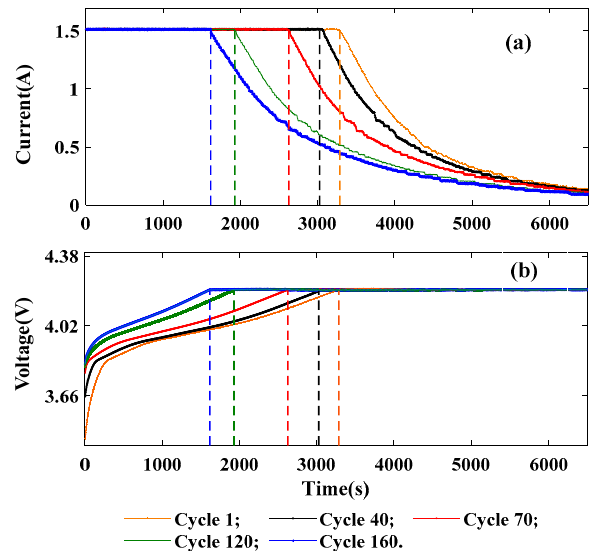
Figure 1. The charge voltage and current curves for different cycles: ( a ) The charge voltage curves, ( b ) The charge current